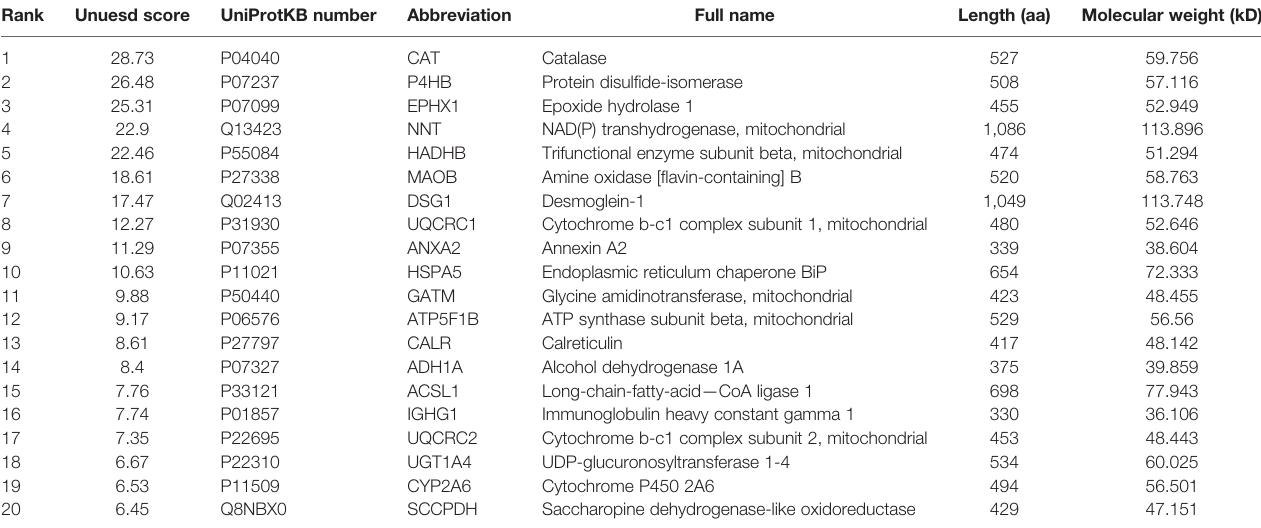
20 proteins with the highest Unuesd scores. aa: amino acid.